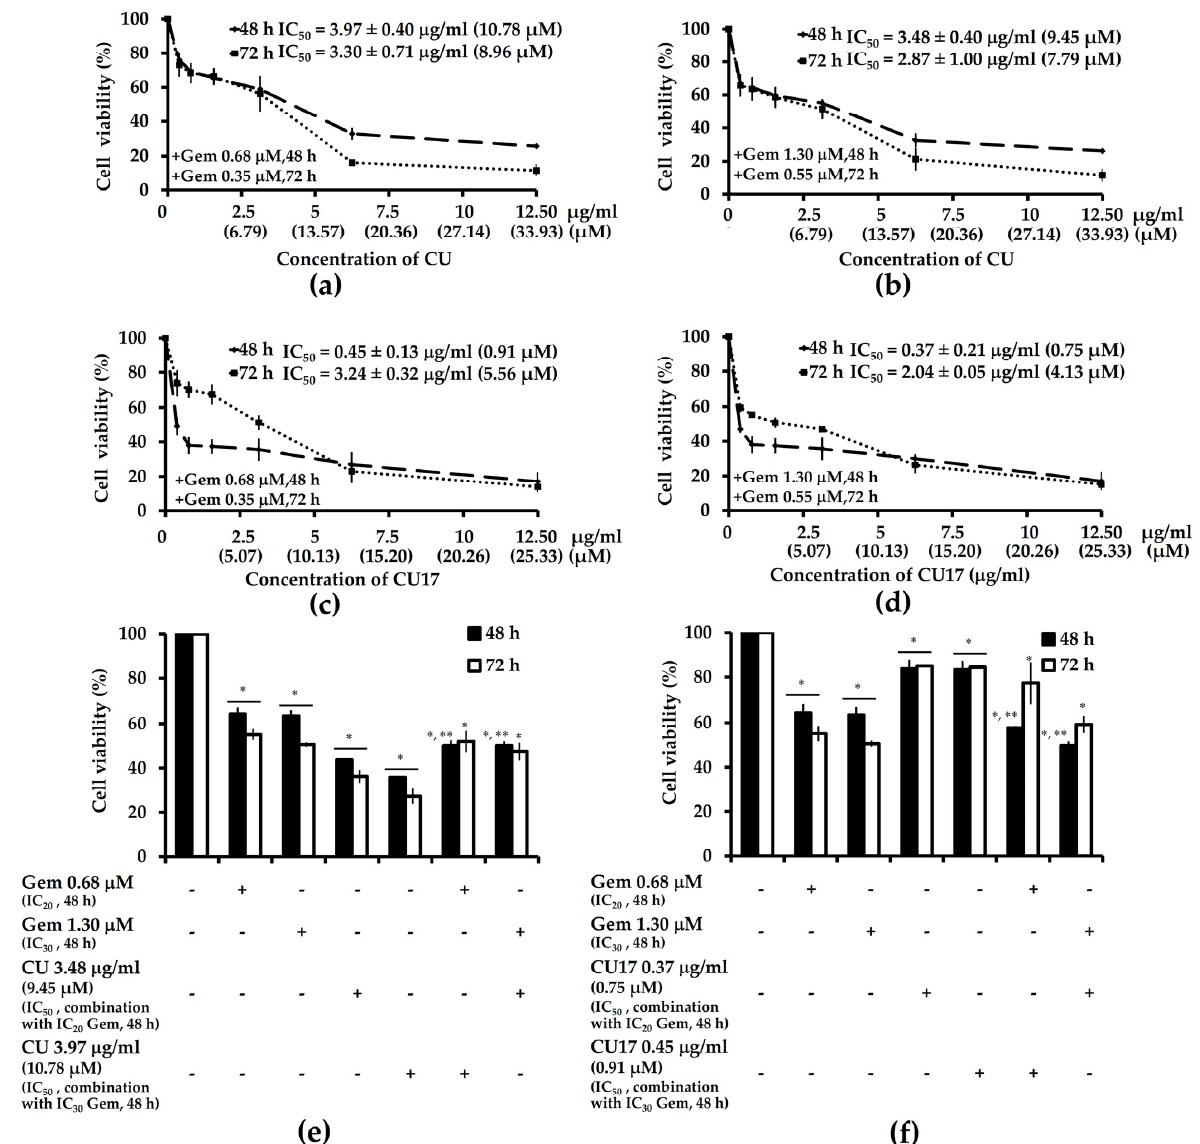
Figure 9. The effect of Gem and CU or CU17 combination treatments on proliferation of A549 cells.